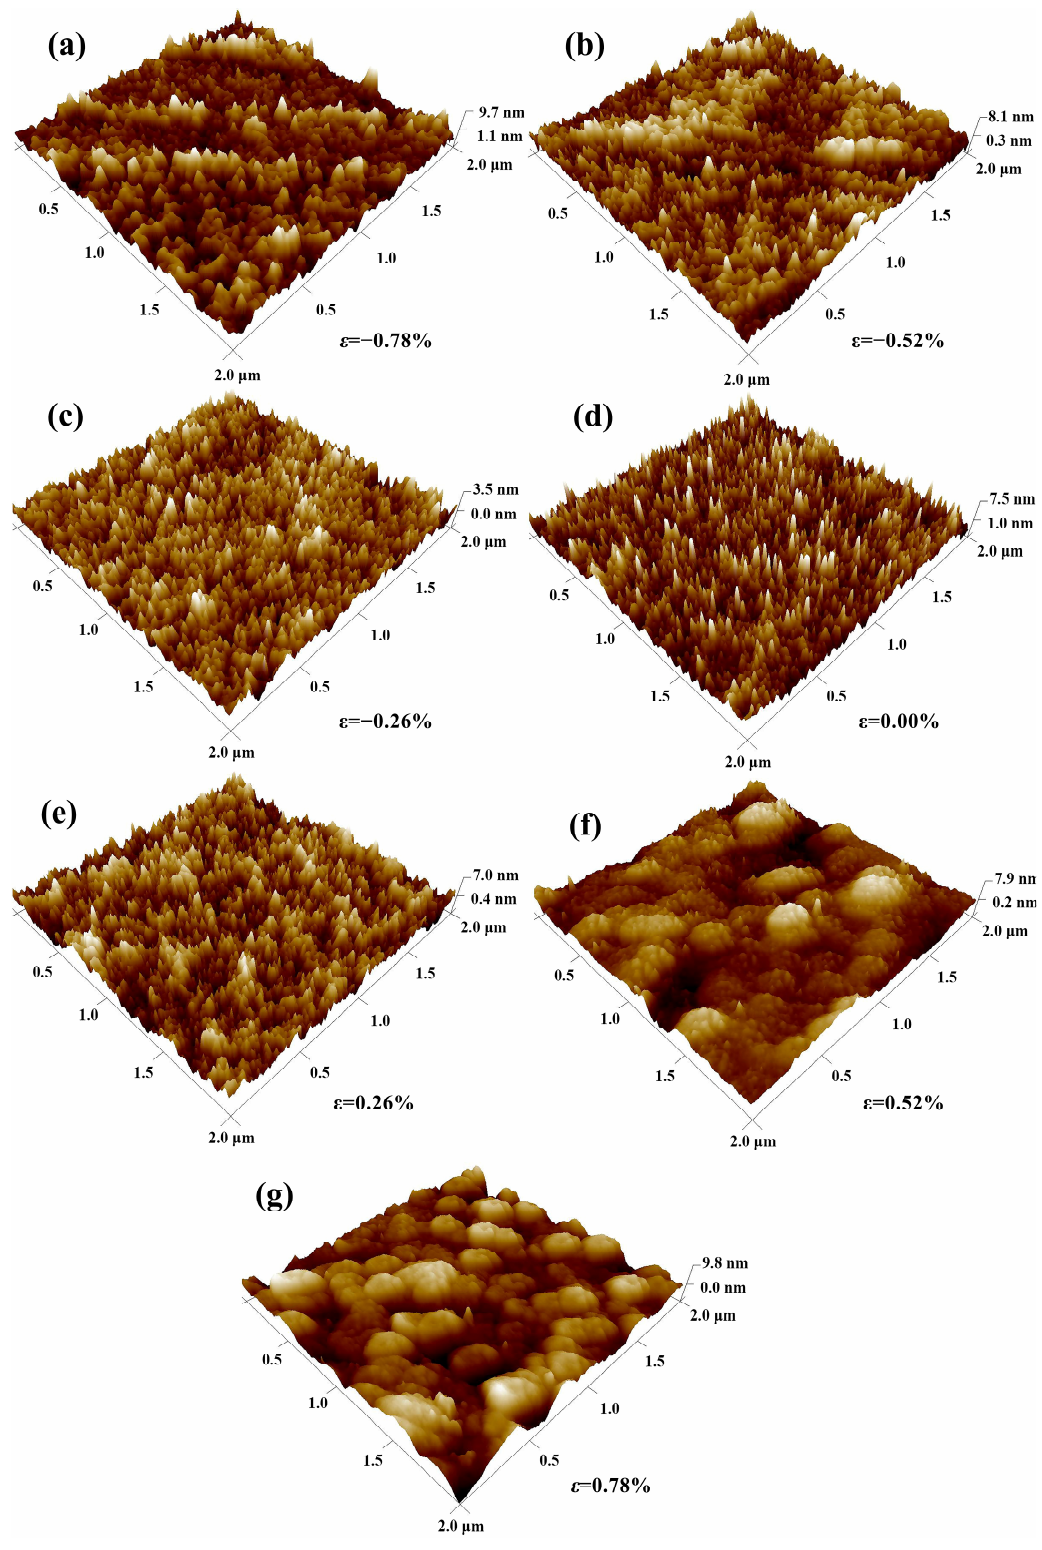
Figure 2. AFM images of the TFNFT multilayer films at various external strains: ( a ) ε = − 0.78%, ( b ) ε = − 0.52%, ( c ) ε = − 0.26%, ( d ) ε = 0.00%, ( e ) ε = 0.26%, ( f ) ε = 0.52%, ( g ) ε = 0.78%.